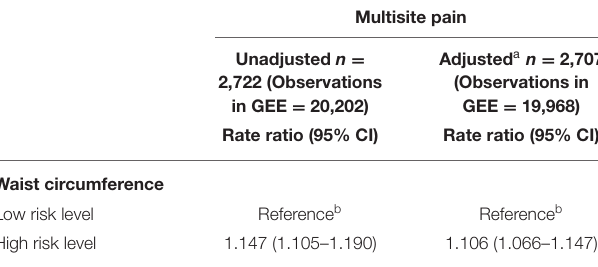
TABLE 4 | Waist circumference high and low risk levels and the rate of having multisite pain among national health and aging trends study participants